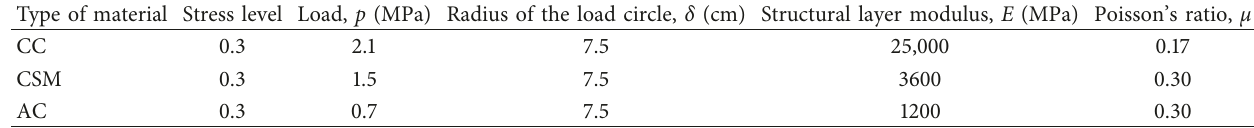
Table 9: Calculation parameters of